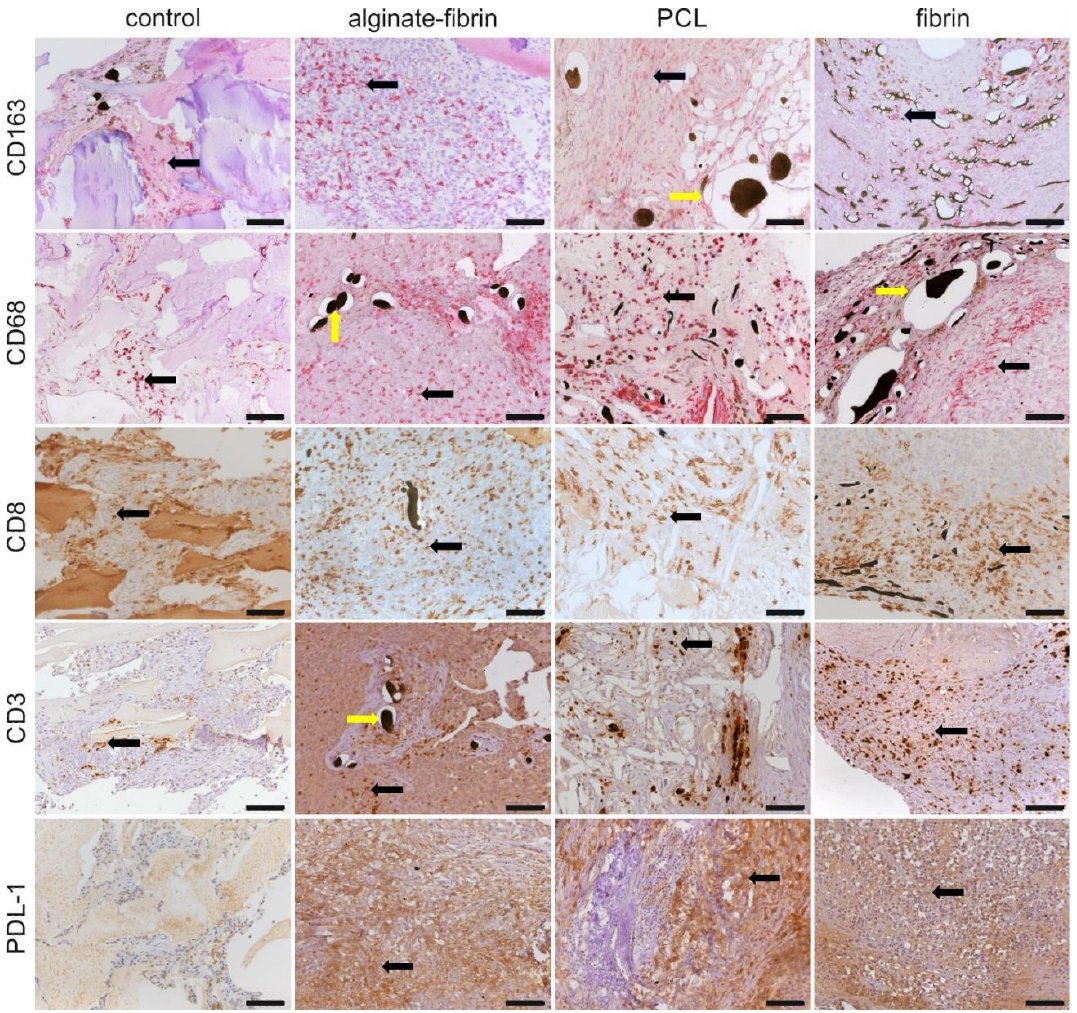
Figure 8. Immunohistochemical staining for tumor associated macrophages and immune cells in the constructs. Representative images of CD163, CD68, CD8, CD3, and PDL-1 immunohistochemical staining in control, alginate – fibrin, PCL, and fibrin groups. Scale bar 100 μm. Black arrows indicate positively stained cells. Yellow arrows indicate perfused vessel.